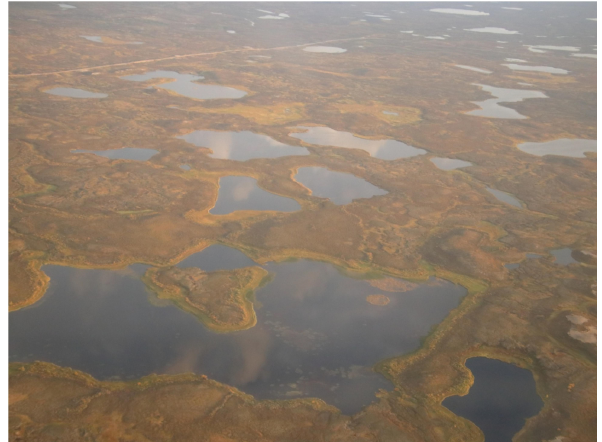
Figure 10. A photo of the Arctic tundra with formed lakes.